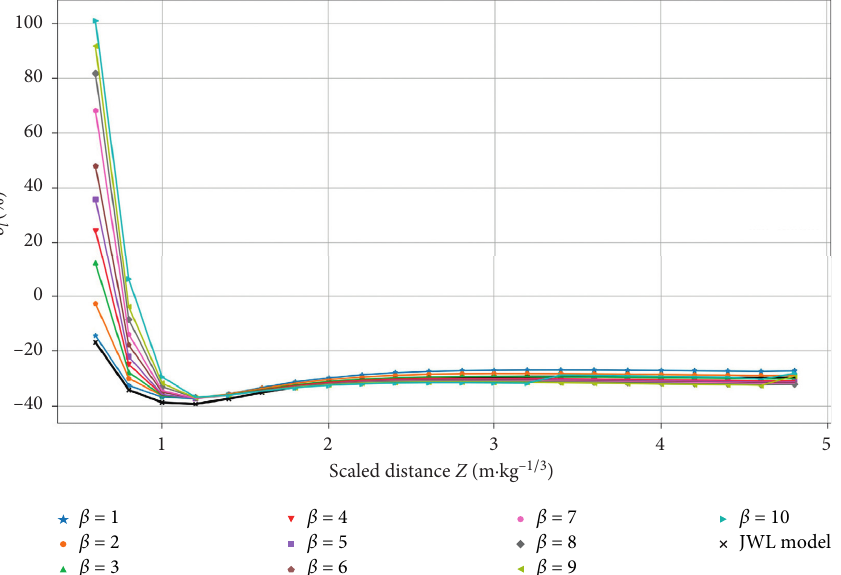
Figure 6: Impulse relative difference δ